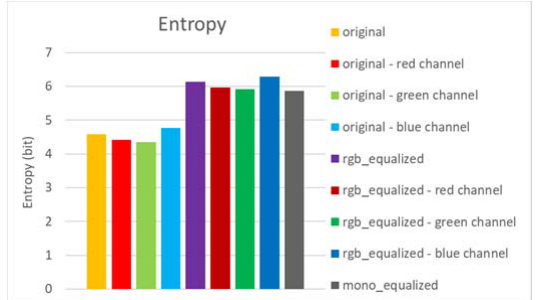
Fig. 5. Entropy of the original image and its variations.